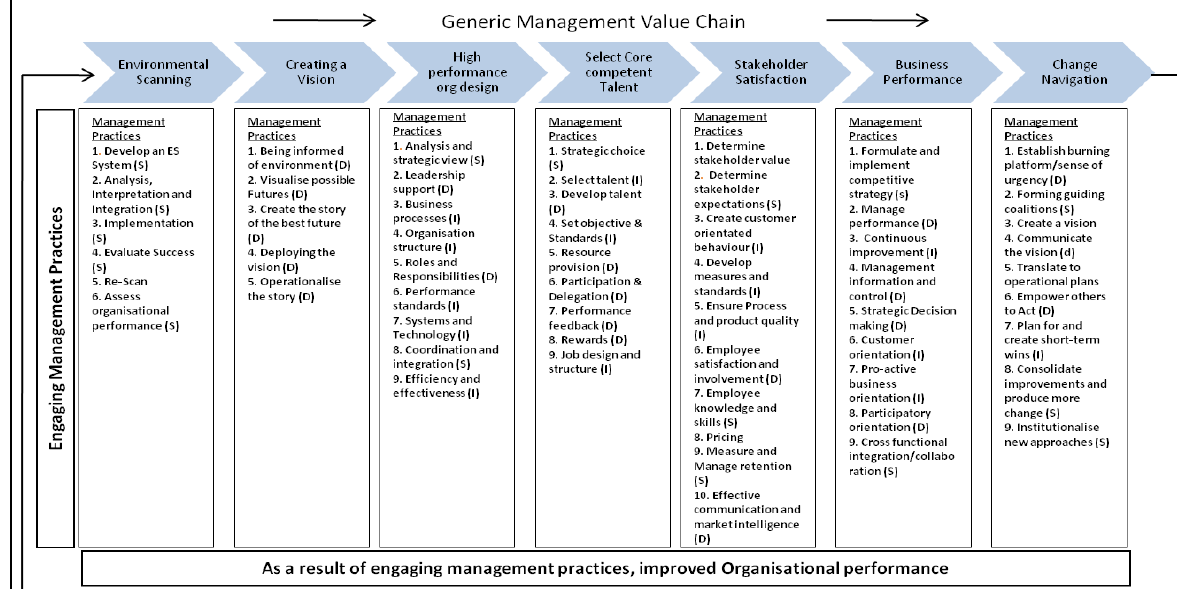
Figure 3: Proposed Generic Management Value